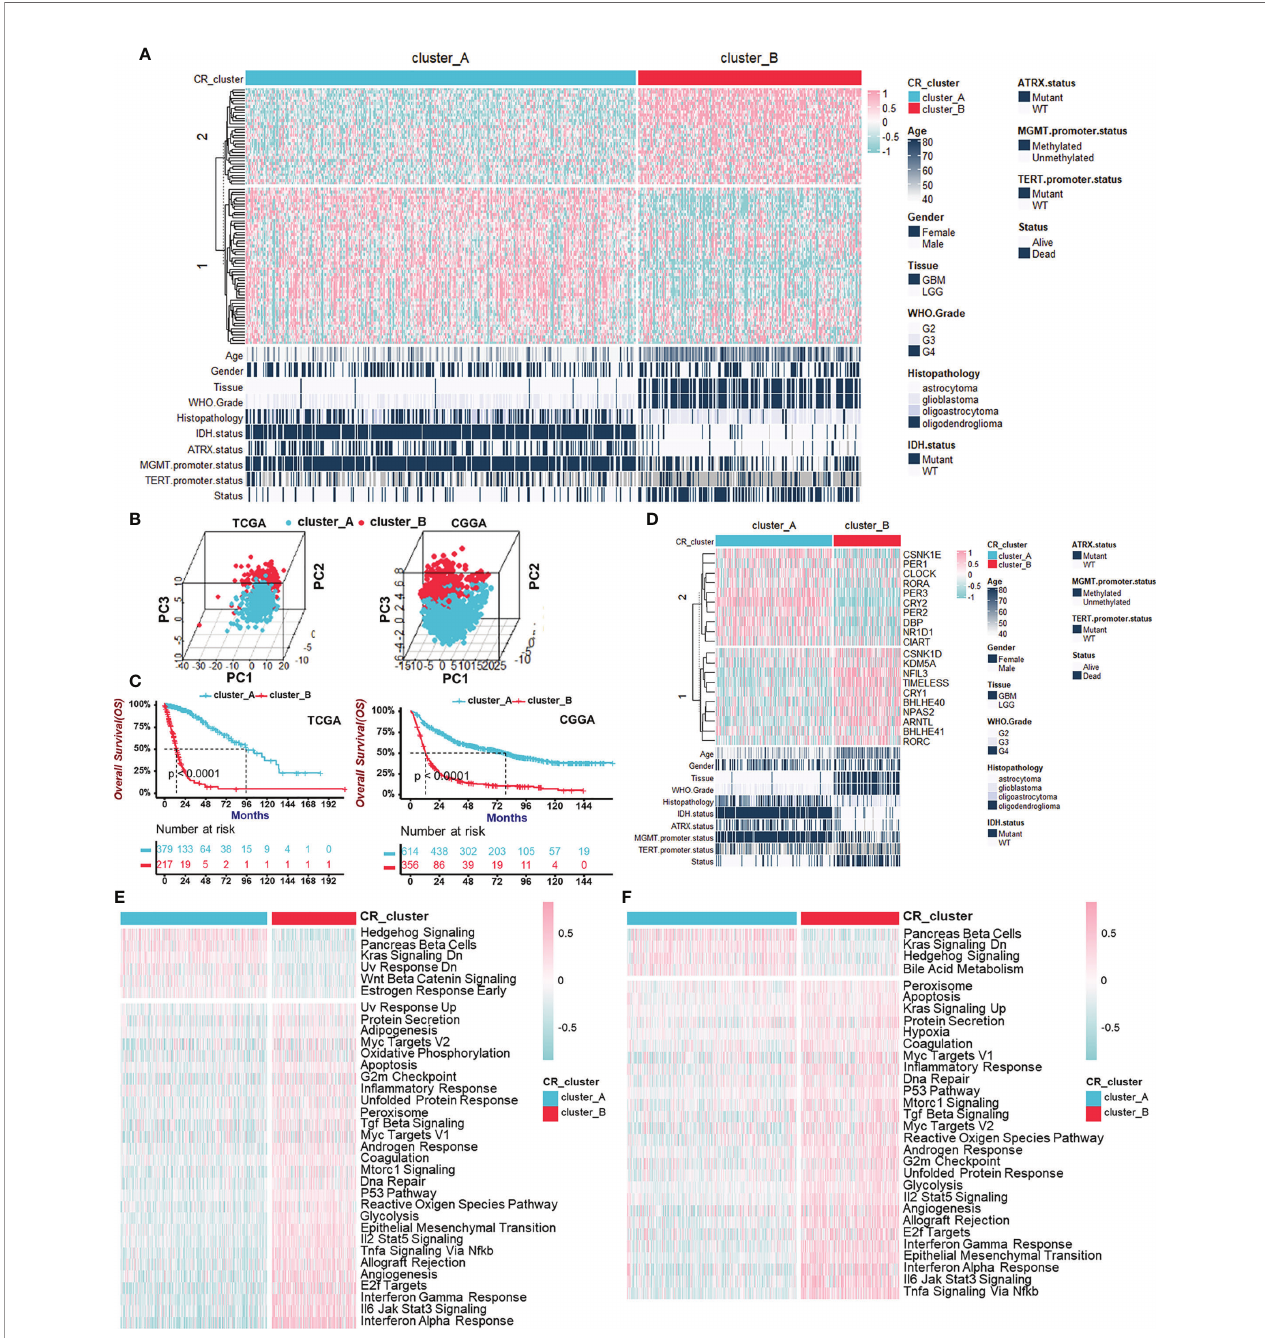
FIGURE 2 | Identi fi cation of two circadian patterns mediated by CR genes in TCGA cohort. (A) Unsupervised clustering of 91 CR genes for 596 glioma patients in the TCGA cohort resulted in two CR clusters. Age, gender, tissue, WHO grade, histopathology, IDH status, ATRX status, MGMT promoter status, TERT promoter status, and survival status are shown as patient annotations. Pink represented the relatively high expression of CR genes and blue represented the relatively low expression. (B) Principal component analyses for the transcriptome pro fi les of CR patterns in TCGA (left) and CGGA (right) cohorts, respectively, showing a remarkable difference on transcriptome between two CR patterns. (C) Survival analyses for CR patterns in the TCGA cohort (left) including 379 cases in CR cluster-A and 217 cases in CR cluster-B (Log-Rank test: p < 0.0001), and in the CGGA cohort (right) including 614 cases in CR cluster-A and 356 cases in CR cluster-B using Kaplan – Meier curves (Log-Rank test: p < 0.0001). (D) The transcriptome of core CR genes with remarkable differences in two CR patterns corresponded with the previous clustering. Pink represented the relatively high expression of core CR genes and blue represented the relatively low expression. (E, F) GSVA enrichment analyses in two CR clusters showing the activation states of Hallmark pathways (MSigDB) in TCGA (E) and CGGA (F) cohorts. Activated pathways, pink; Inhibited pathways,